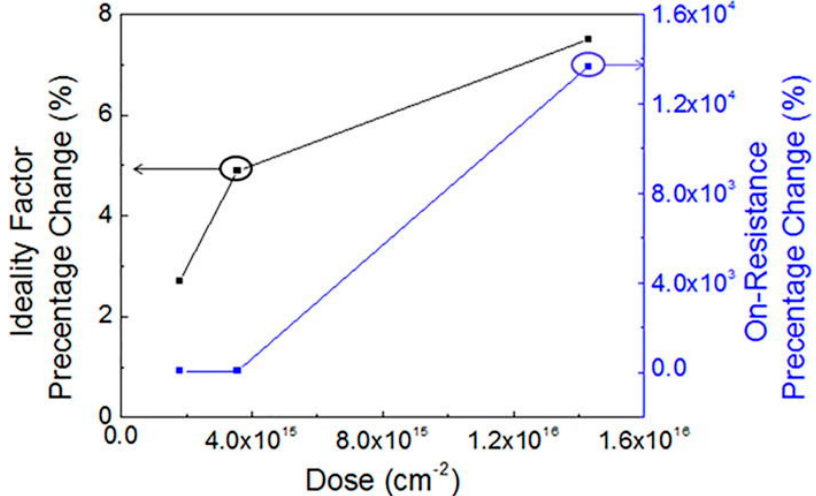
Figure 8. R on and η as a function of electron fluence. Reprinted/adapted with permission from Ref. [81], 2017, American Vacuum Society.